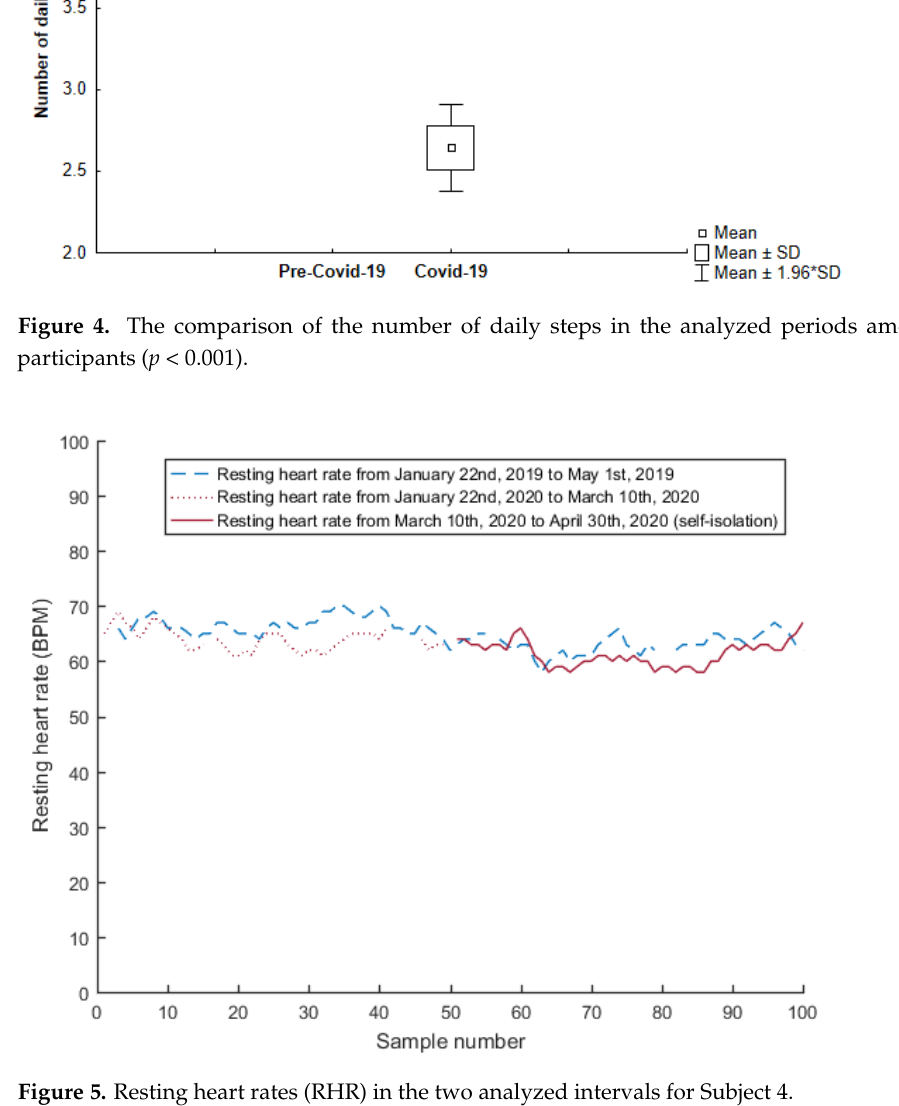
Figure 5. Resting heart rates (RHR) in the two analyzed intervals for Subject 4.